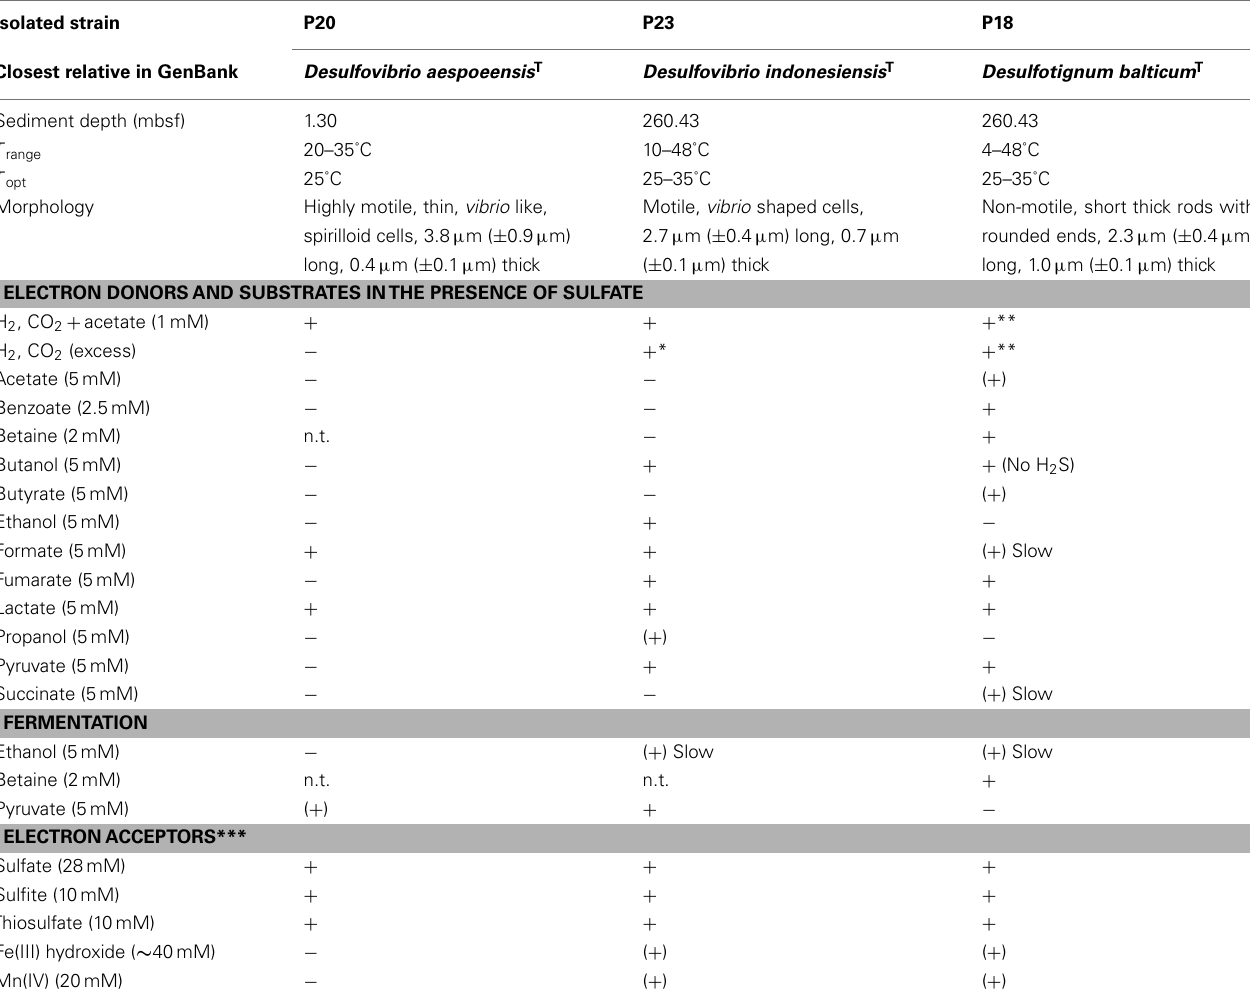
Table 2 | Comparison of characteristics of sulfate-reducing isolates from IODP Site U1301: temperature range of growth, morphology, substrate utilization, and alternative electron